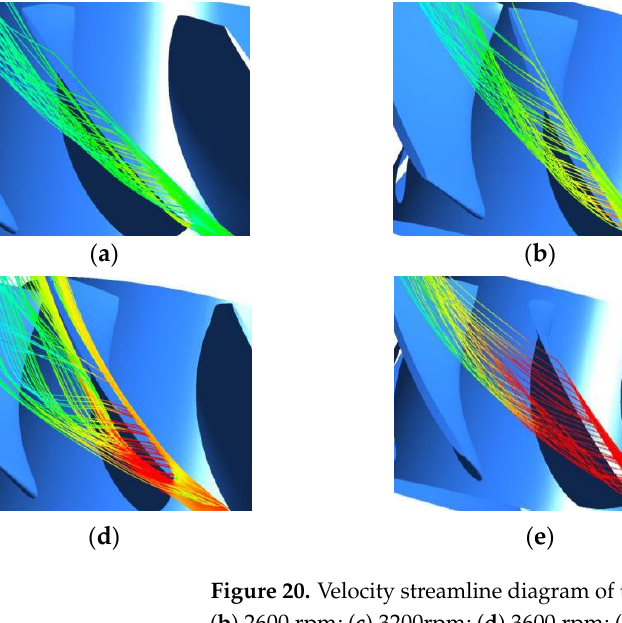
( f ) Figure 21. Velocity of the rotor blade tip at different rotating speeds (( a ) 2000 rpm; ( b )2600 rpm; ( c ) 3200 rpm; ( d ) 3600 rpm; ( e ) 4000 rpm; ( f ) legend). Figure 22 shows the velocity of the rotor blade tip at different oblique angles and cavitation numbers. Clearly, the influence of the cavitation number on the tip clearance flow field is greater than that on the oblique flow angle. Under pure axial flow condi- tions and °= 01 β (Figure 22a–c), the low-velocity area of the rotor suction surface in- creases with decreasing cavitation number. The sufficient mixing of the low-velocity area and the mainstream affects the rotor domain at the lower cavitation number